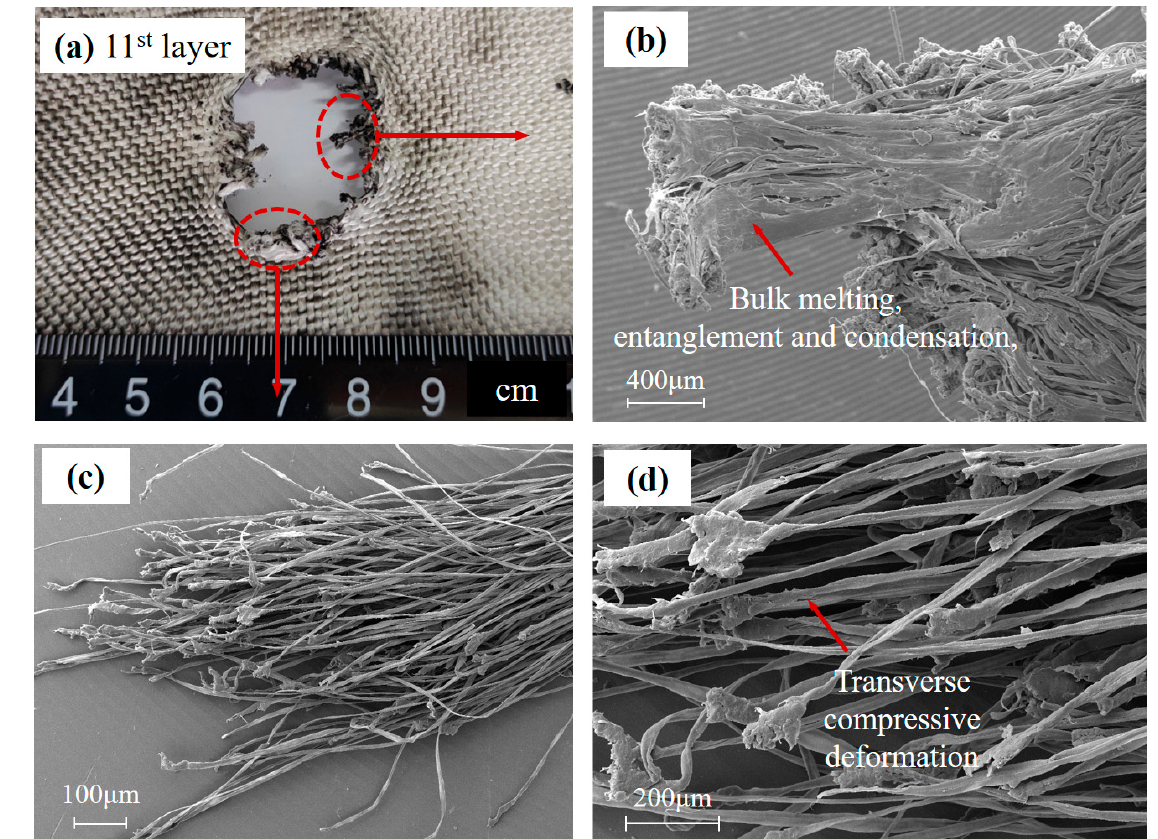
Figure 9. Typical impact feature in UHMWPE yarns. ( a ) The hole in UHMWPE fabric. ( b ) Melting UHMWPE fiber yarn. ( c ) The plastic deformation UHMWPE fiber. ( d ) The broken UHMWPE fiber cross-section.